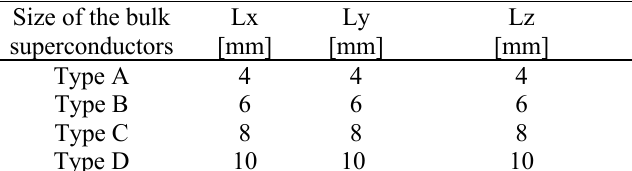
Table 1: Geometrical properties of bulk superconductors used in our simulations.